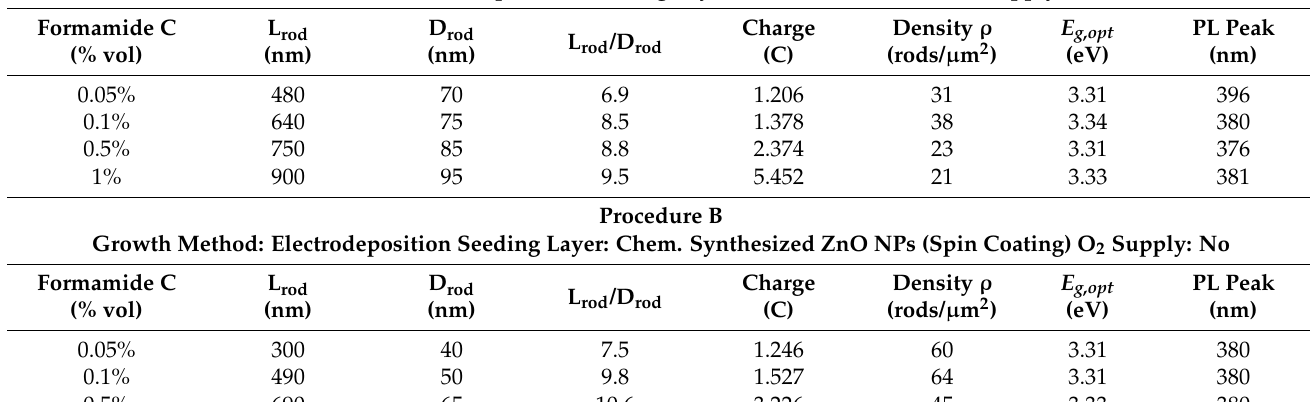
Table 1. Experimental data for different formamide concentrations for each of the three procedures A, B and C: formamide concentration C, length L rod , diameter D rod and the aspect ratio L rod /D rod of ZnO nanorods, the transferred charge during electrochemical growth, the density of ZnO nanorods, the optical energy gap E g,opt calculated from UV-vis measurements and the wavelength of the maximum intensity from PL